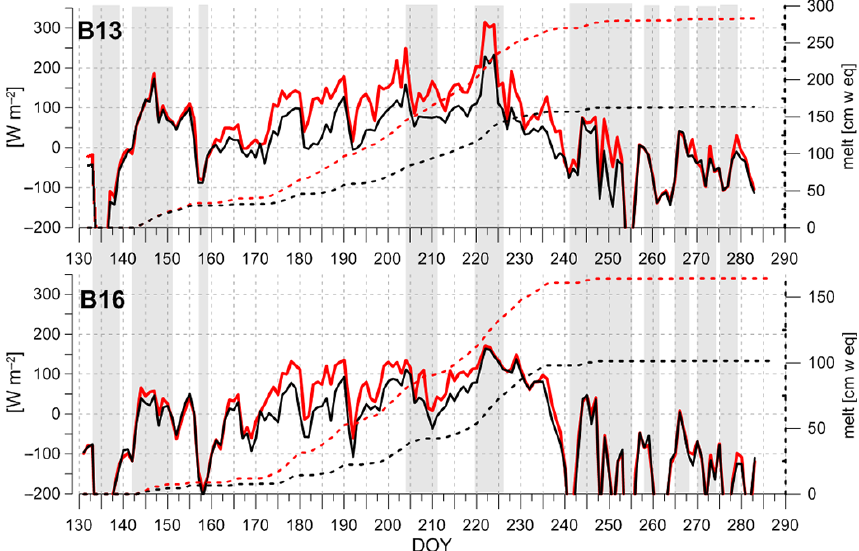
Figure 8. Measured energy balance (red line) and energy balance with simulated albedo with HIRHAM5 (black line) for a clean glacier surface without dust at the stations B13 (upper graph) and B16 (lower graph). Cumulative snowmelt is shown in dotted lines for AWSs in red and HIRHAM5 in black. Highlighted in grey are modelled dust event periods by